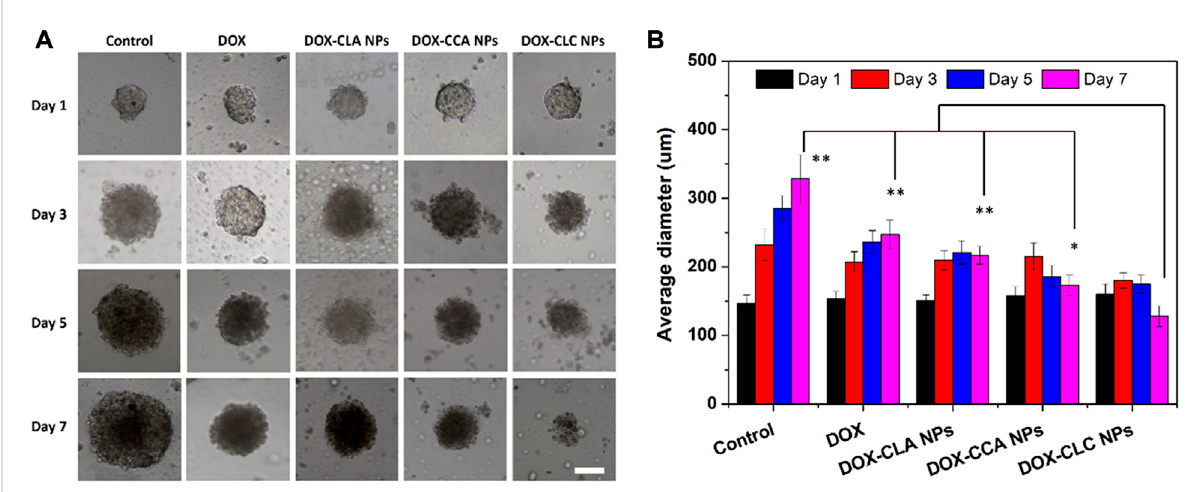
FIGURE 7 The growth inhibition of HepG2 MCs after co-incubating with free DOX, DOX-CLA NPs, DOX-CCA NPs and DOX-CLC NPs for 7 days (A) , scale bar = 100 um; The average diameter changes of MCs during the treatment were measured by ImageJ, n = 3 (B) ; * represents p < 0.05, ** represents p < 0.01 at day 7.